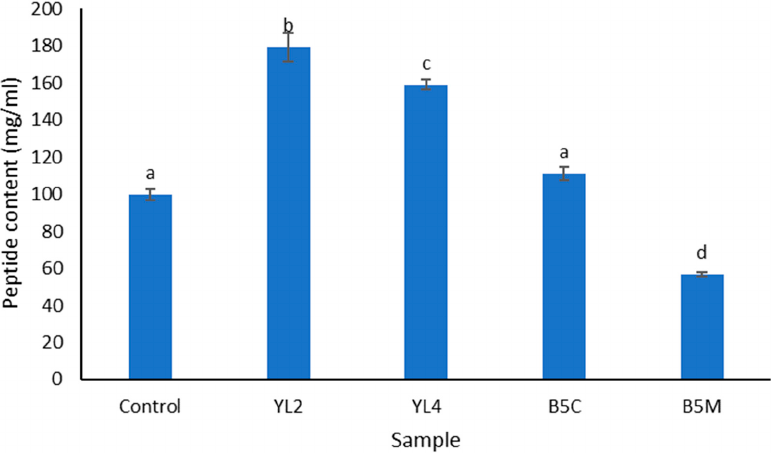
Figure 2. Degree of hydrolysis (DH) expressed in percentage for the samples and measured after 72 h incubation. YL2 and YL4 ( Y. lipolytica ), B5C ( B. subtilis ), and B5M ( B. amyloliquefaciens ). Results are the average of three replicates ( n = 3). Different letters mean results are significantly different ( p < 0.05).